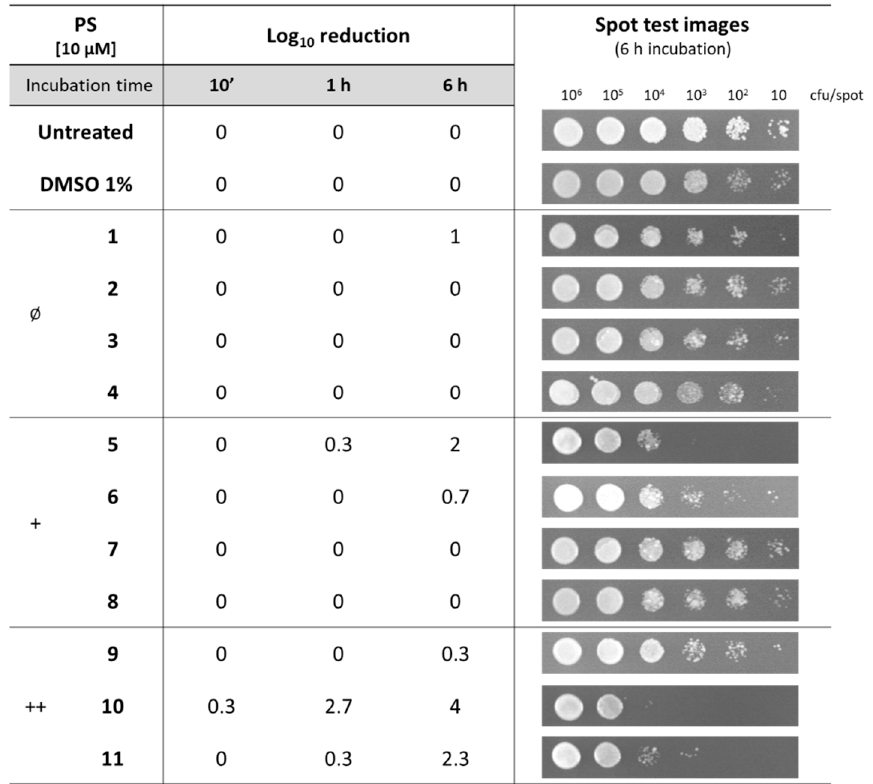
Figure 2. Intrinsic toxicity of the diaryl-porphyrins ( 1 – 11 ) on Candida albicans cells upon 10 min, 1 h, and 6 h of incubation in the dark. The neutral (Ø), monocationic (+), and dicationic (++) porphyrins were administered at a concentration of 10 µM. Log 10 reduction values represent the mean of at least three independent experiments. In the last column, representative spot test images upon 6 h of dark incubation are presented.